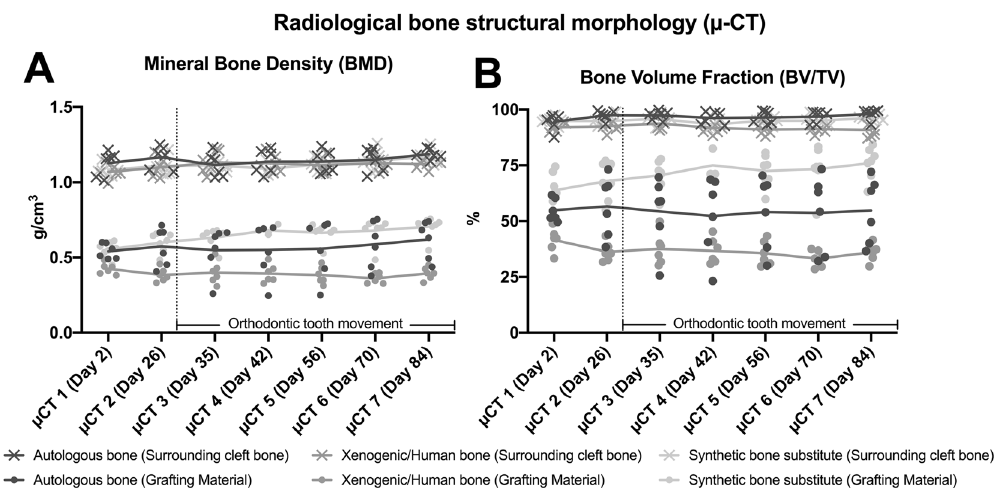
Figure 8. Radiological bone changes in the ( A ) bone mineral density (BMD) and ( B ) bone volume fraction (BV/TV) of the grafting materials and the bone surrounding the cleft in the maxillary reconstruction: line diagram of the mean values in the context of the bone structural morphology behavior over time.